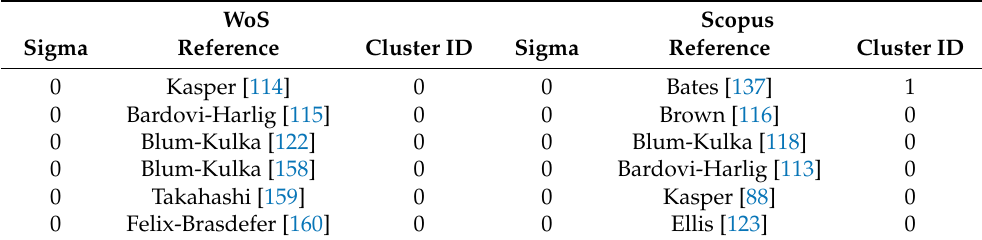
Table 10. Sigma metrics for top 10 authors in pragmatic language development.